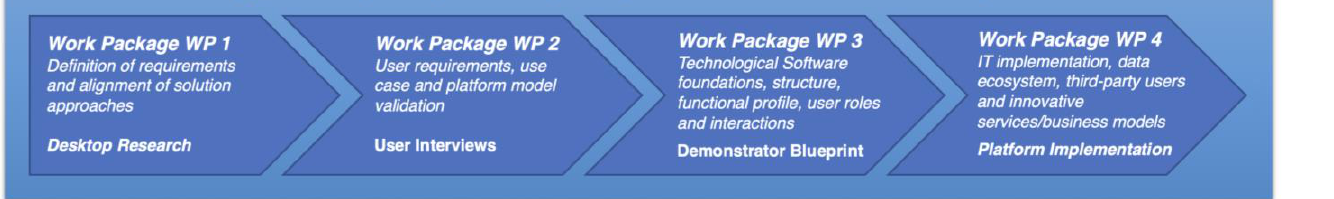
Figure 2. Research methodology consisting of desktop research (WP1), user interviews (WP2), demonstrator blueprint (WP3) and platform implementation (WP4); based on authors’ own depiction.